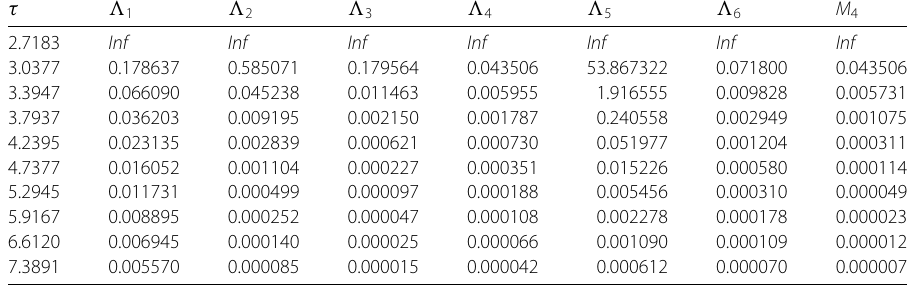
Table 2 Numerical values of (cid:19) 1 , (cid:19) 2 , (cid:19) 3 , (cid:19) 4 , (cid:19) 5 , (cid:19) 6 , and ˘ M 4 in Example 6.1 for τ ∈ J